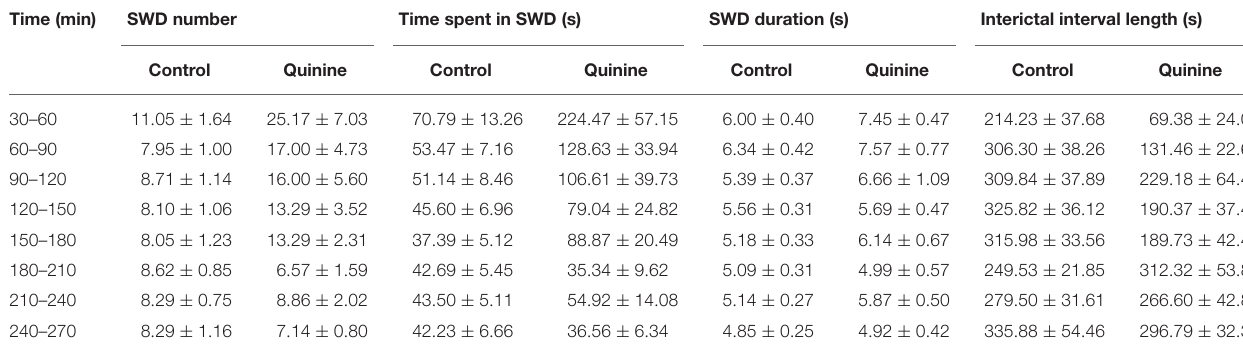
TABLE 3 | Synchronous spike-wave discharge parameters in WAG/Rij rats ( n = 7) in control conditions and after i.p. administration of 40 mg/kg quinine. Time